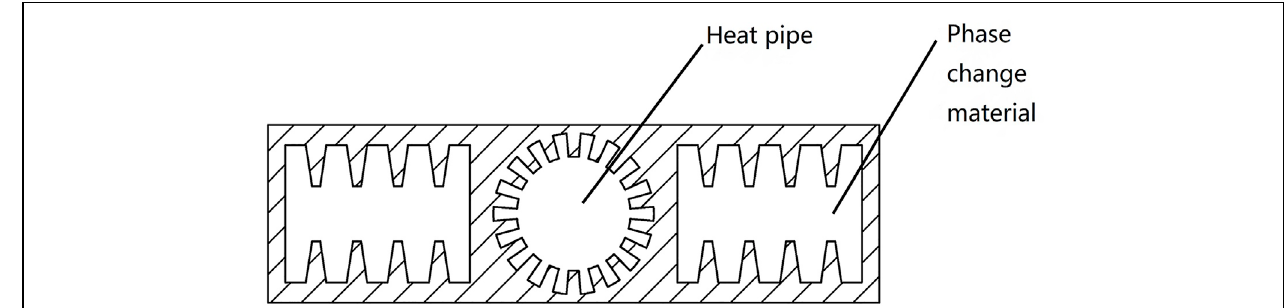
FIGURE 5 | Schematic diagram of heat pipe with phase change